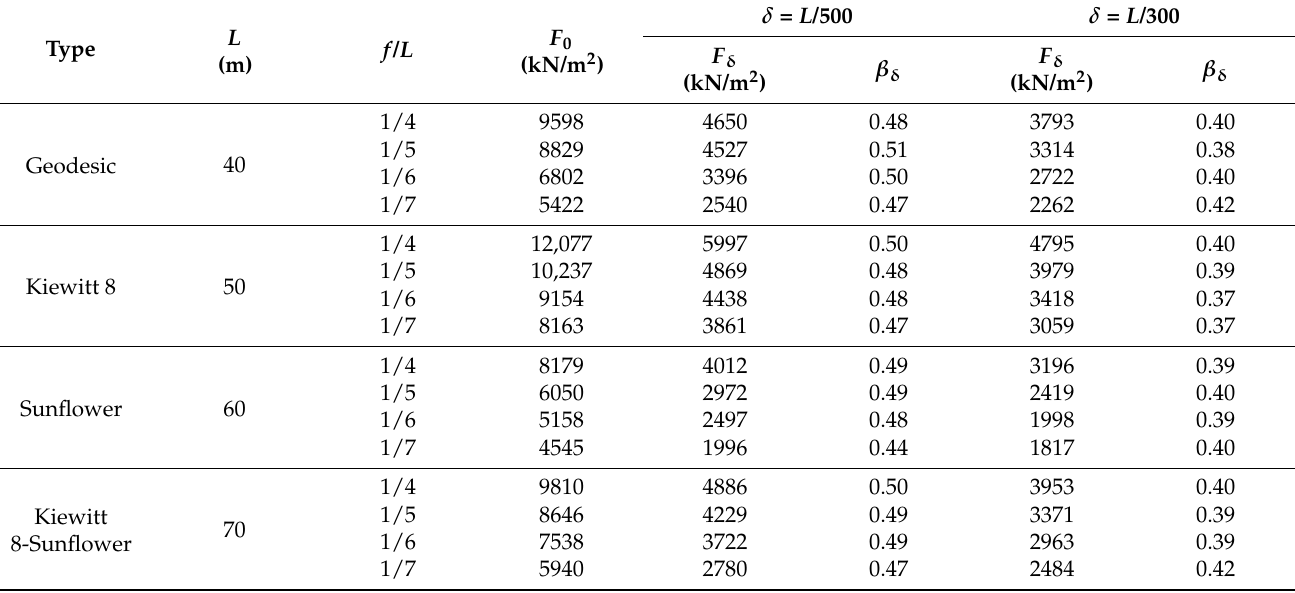
Table 5. Defect coefficient under the IGDM with L /300 and L